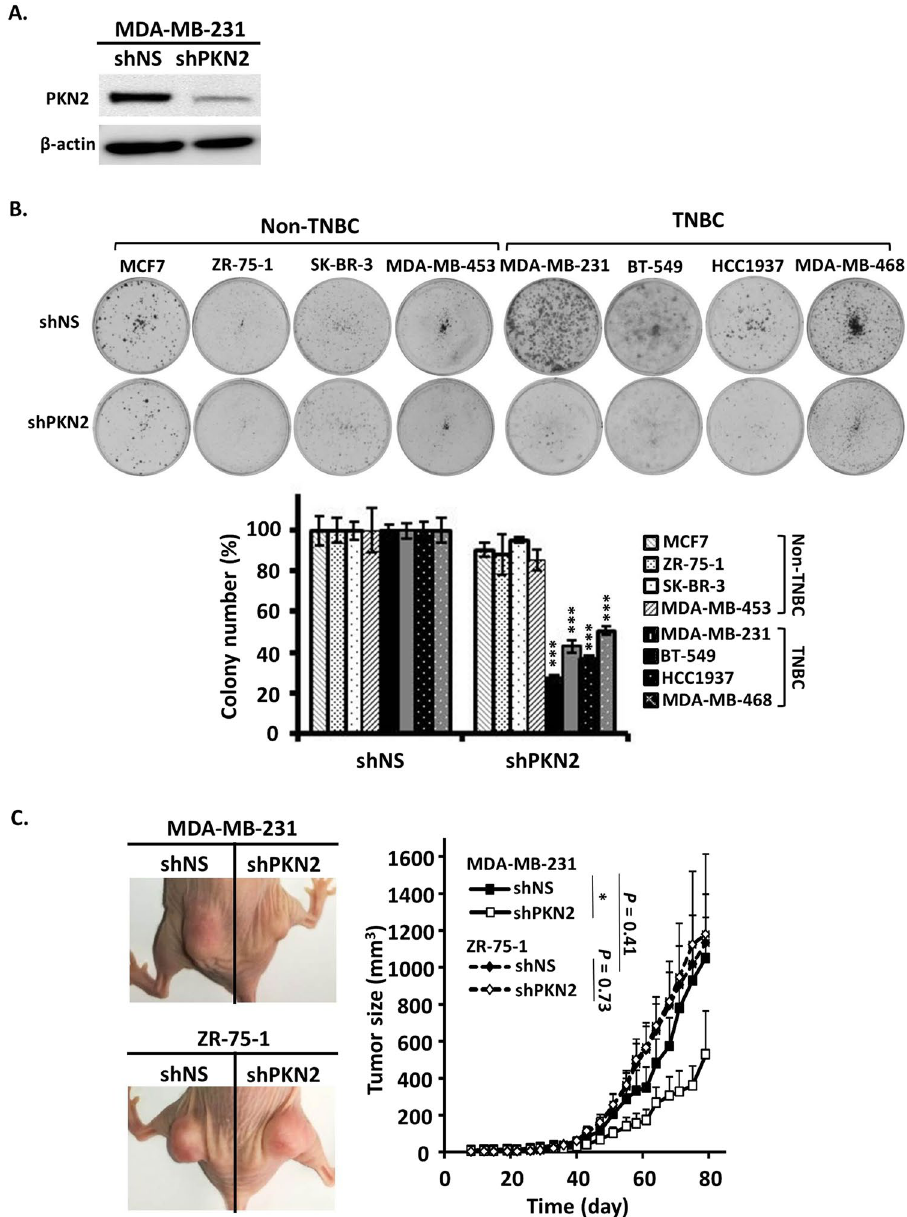
Figure 4. PKN2 expression is essential for TNBC cell growth. Breast cancer cell lines were transduced with either nonspecific shRNA (shNS) or PKN2-specific shRNA (shPKN2) lentivirus and selected with puromycin for 3 days. ( A ) Western blotting analysis of PKN2 after lentiviral knockdown as exemplified in MDA-MB-132 cells. ( B ) Effect of PKN2 knockdown on colony formation of non-TNBC and TNBC cell lines. Representative colony formation assay plates are shown, which were quantified by counting colony number (n = 4). ( C ) Effect of PKN2 knockdown on xenograt formation of TNBC MD-MB-231 cells and non-TNBC ZR-75-1 cells. Left panel, xenograft pictures of one representative mouse for each cell line. Right panel, tumor growth curve over time (n = 9). P values were calculated on day 79 after cell injection. Data are shown as mean ± SD. P-values determined by Student’s t-test. * P < 0.05; *** P <